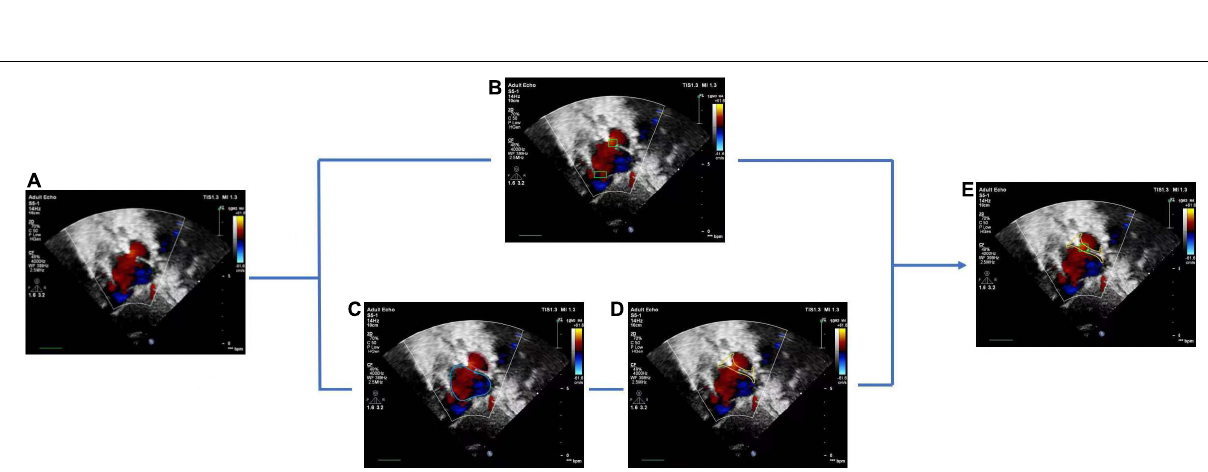
Frontiers in Cardiovascular Medicine |